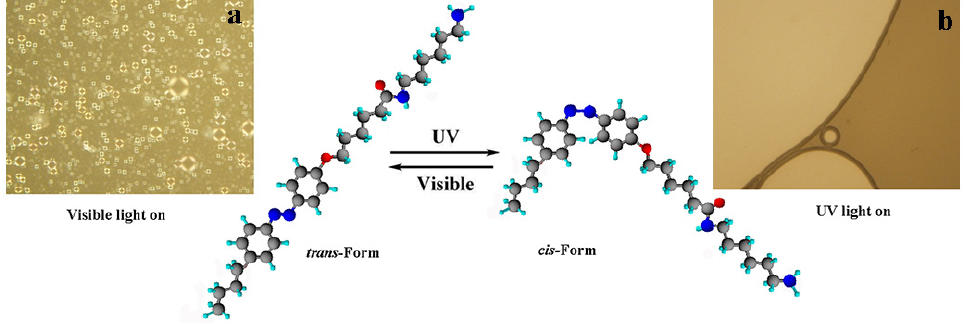
Figure 7. C4-Azo-C5-HDA used as an emulsifier dissolved in water and n-hexane solvent: ( a ) under natural light and ( b ) UV light at 20 °C.